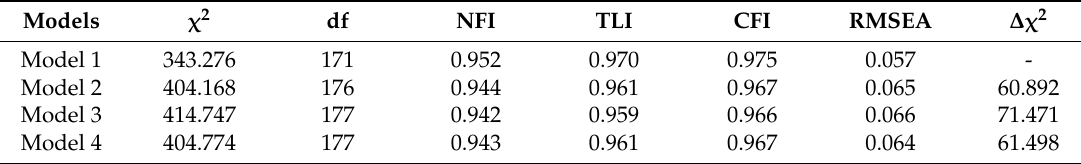
Table 3. Results of model comparisons.